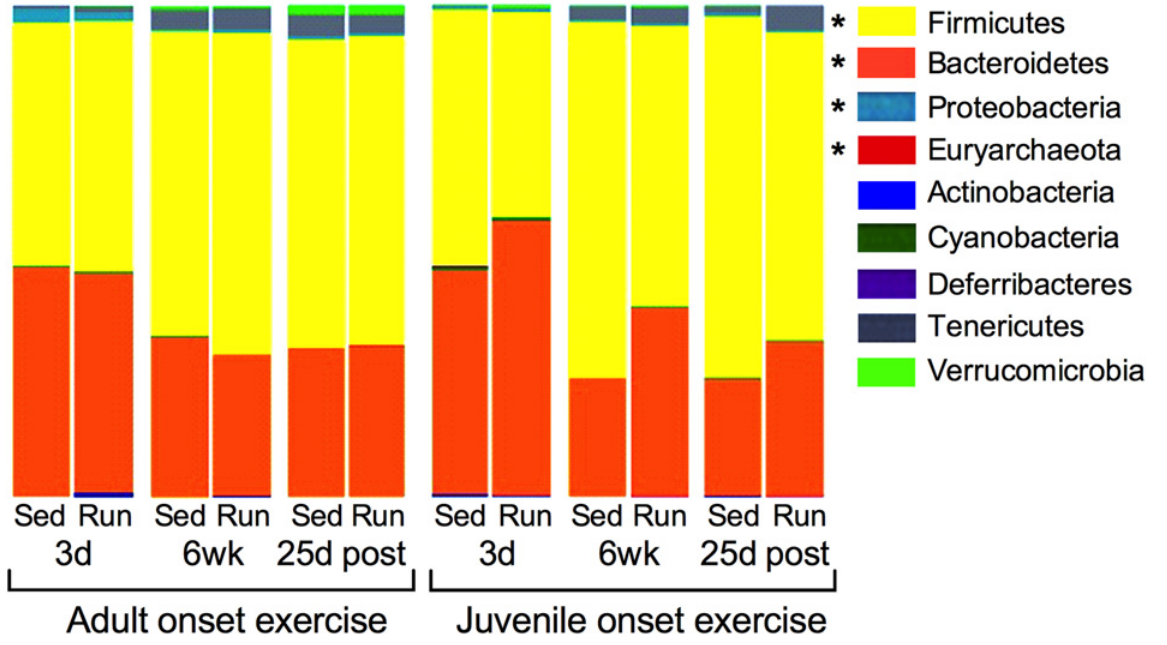
Fig 4. Effects of early life exercise at the phylum level. The relative abundance of nine phyla for adult and juvenile run and sed rats following three days (3d) and six weeks (6 wk) of exercise, and 25 days following exercise cessation (25d post). Significant differences in phyla due to exercise were only observed in juvenile runners. Specifically, juvenile onset exercise increased relative abundance of Euryarchaeota and Bacteroidetes and decreased relative abundance of Firmicutes and Proteobacteria, overall as well as at 6 wk. * p < 0.05.